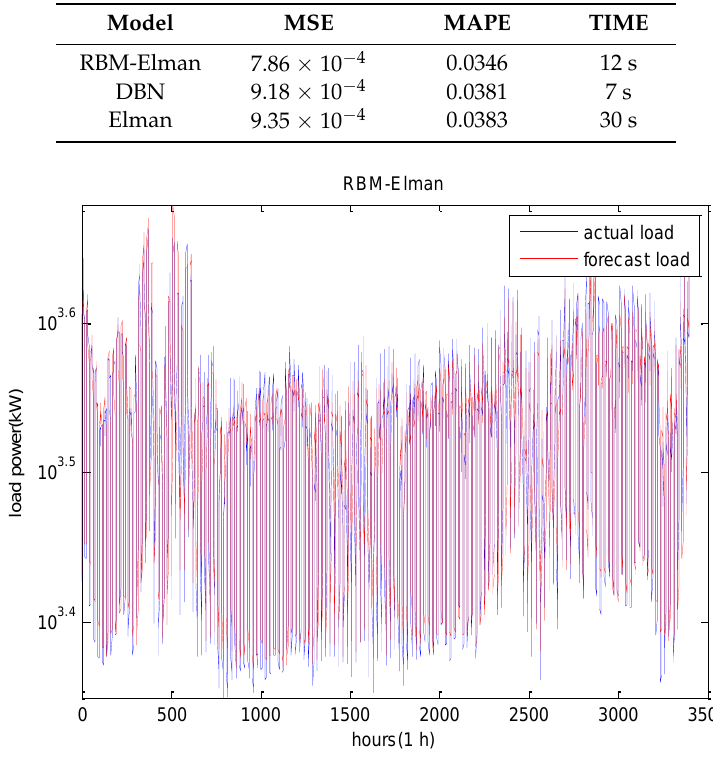
Figure 8. The forecast results using RBM-Elman model for test data.